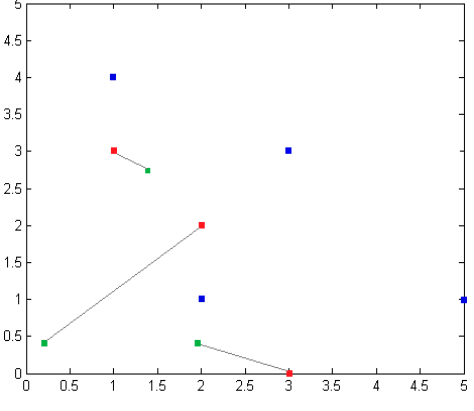
Figure 25. Node location map.